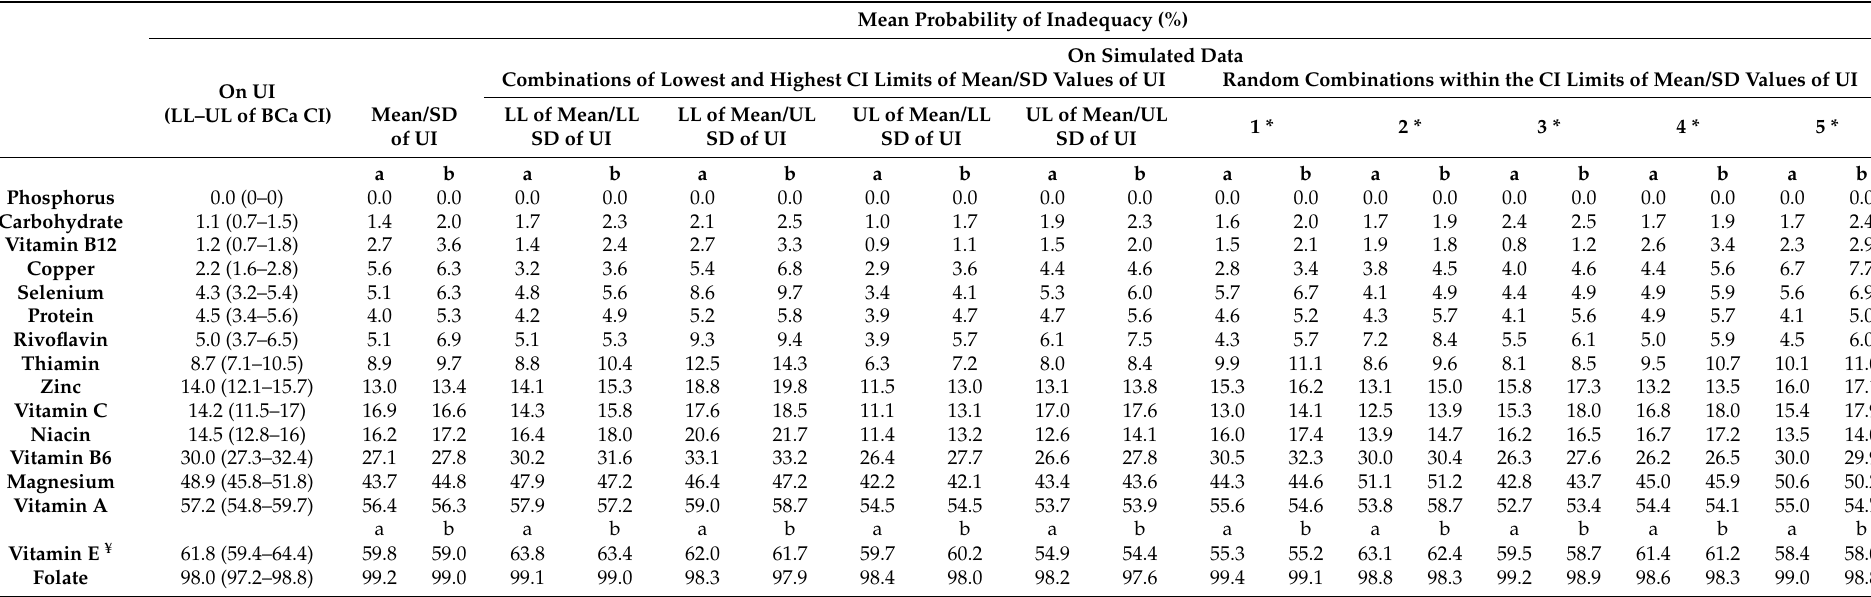
Table 5. Mean Probability of Inadequacy on raw and simulated data of usual